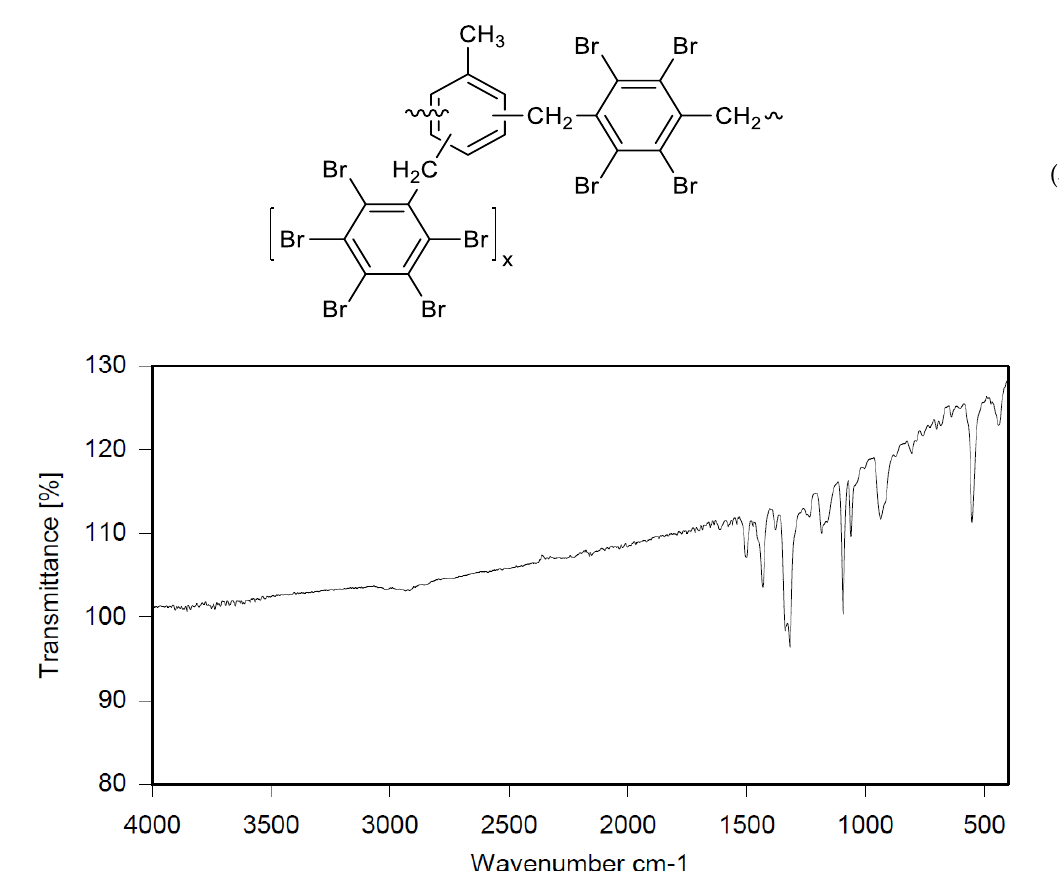
Figure 3. FTIR spectrum of toluene alkylated with PBBB and tetrabromoxylylene dibromide (T-PBBB- TBXDB).